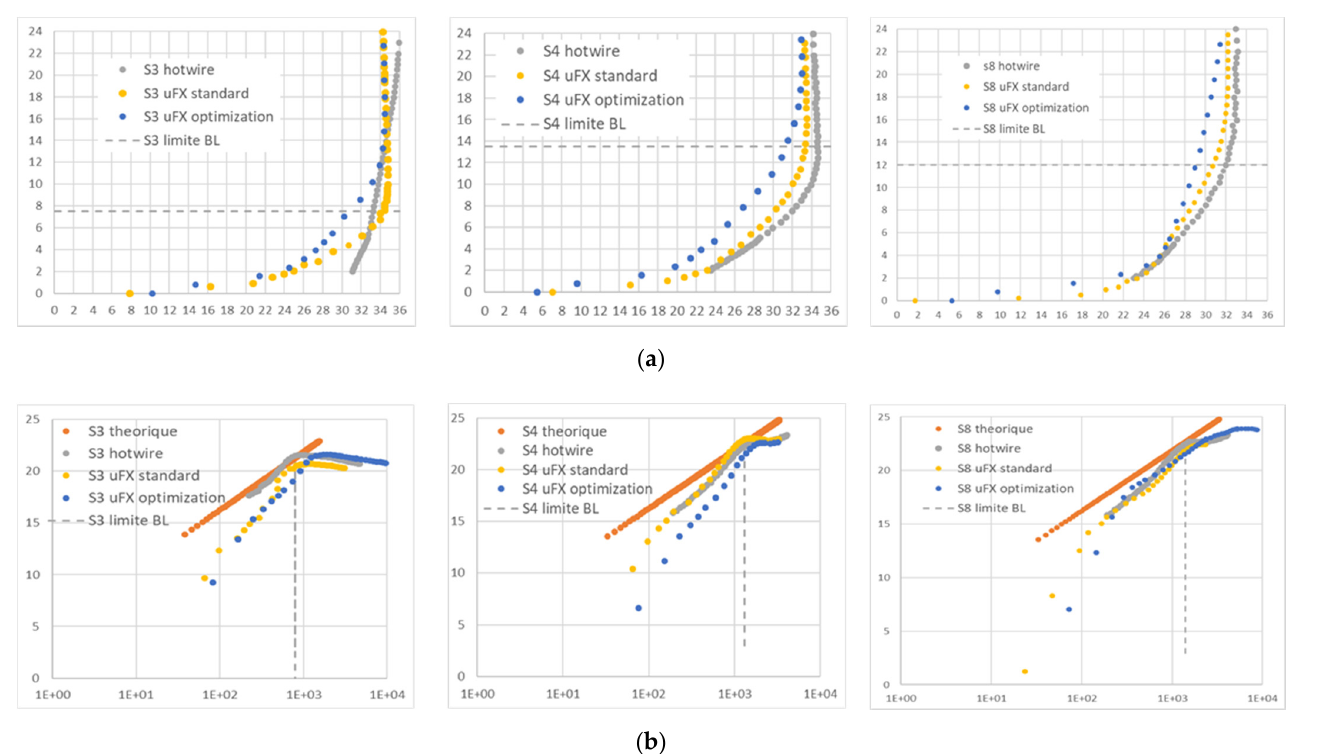
Figure 5. ( a ) Velocity profiles at different locations (on the fender for sensor 3, below the front window for sensor 4 and below the rear window for sensor 8) thanks to hotwire measurements in grey, with a fine mesh in yellow and with a coarse mesh in blue. ( b ) Experimental and numerical non-dimensional velocity profiles at different locations. End of the logarithmic law correspond to the end of the boundary layer. uFX Standard corresponds to the fine mesh and uFX optimization to the coarse mesh. The theorique profiles are computed thanks to Equation (4).